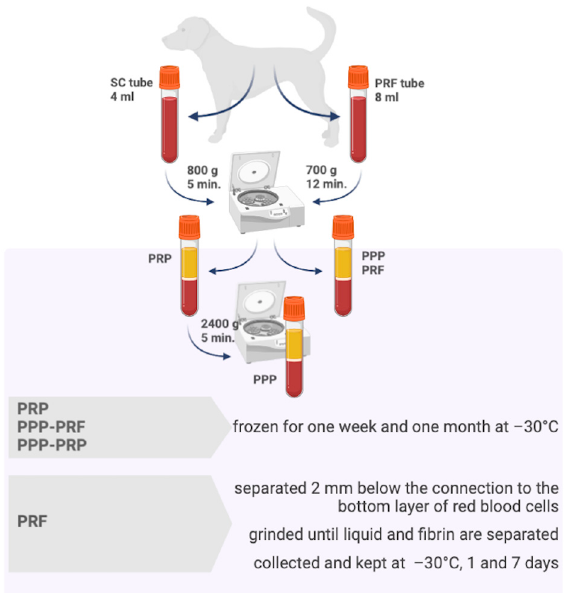
Figure 1. Preparation of platelet-rich fibrin and other autologous blood products of canine. The scheme was created using BioRender.